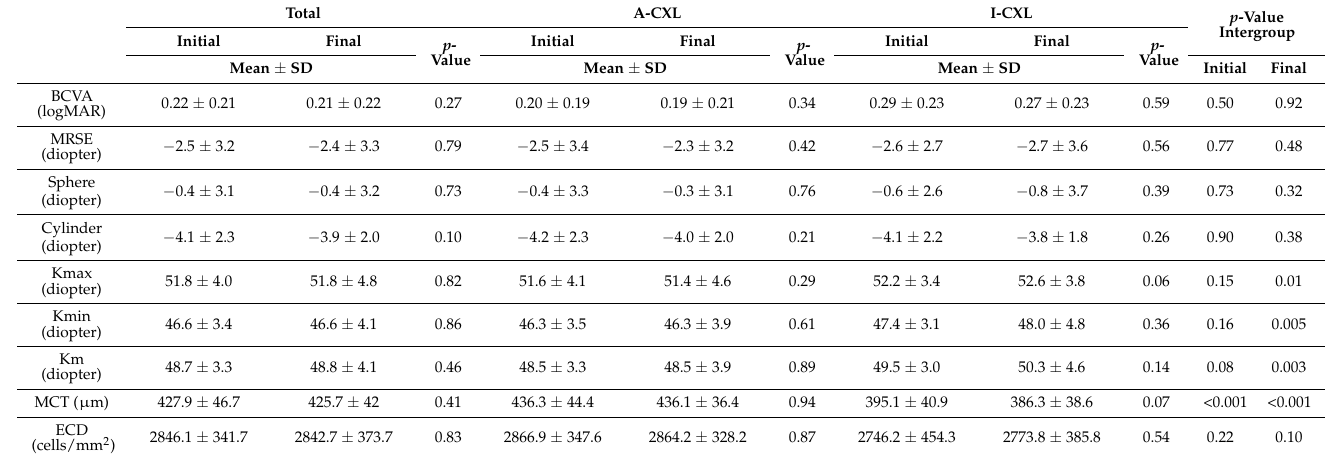
Table 2. Outcomes change from baseline to last visit for the whole cohort and within groups.